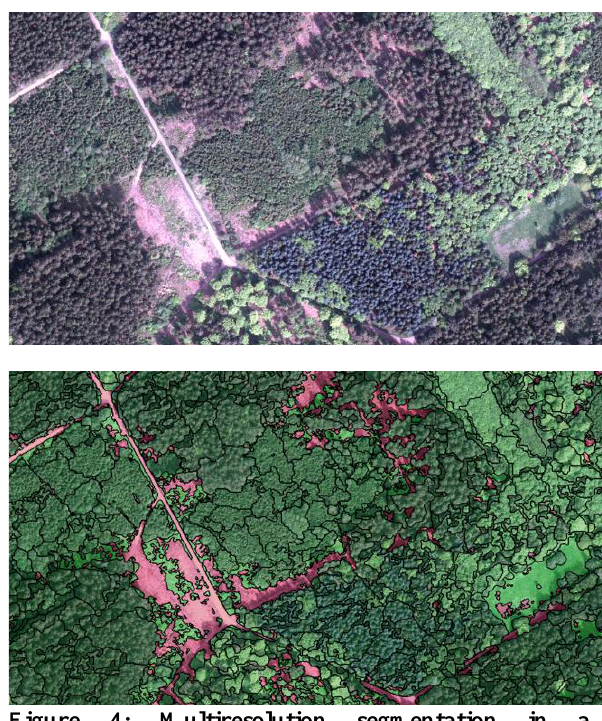
4: Multiresolution segmentation in a heterogeneous forested area